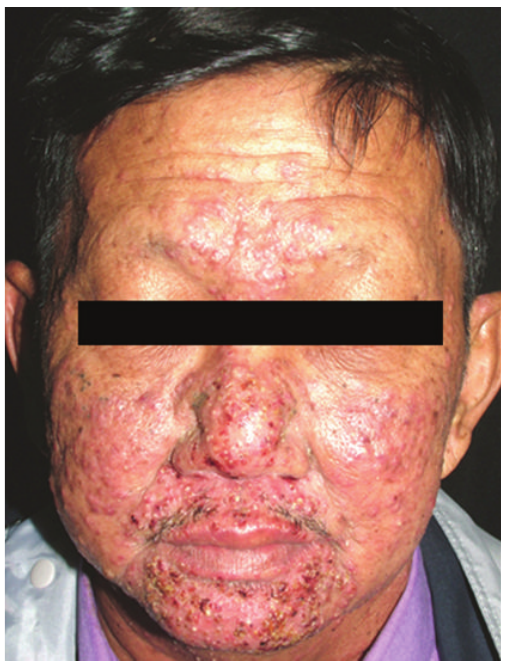
Figure 1: Papulopustular eruption. A 52-year-old man with non- small-cell lung carcinoma stage IV developed papulopustules 6 days after erlotinib was